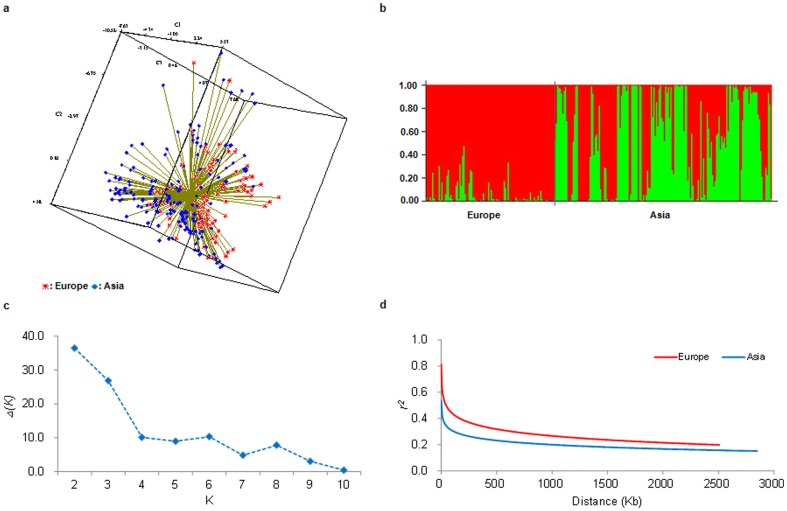
Analysis of genetic relationships, population structure and LD decay in European and Asian wheat accessions.(a) Principal coordinate analysis of European (red) and Asian (blue) accessions. (b) Bayesian clustering (STRUCTURE, K = 2) of wheat accessions. (c) Estimation of the number of populations by calculating delta K values. (d) Average LD decay in European (red) and Asian (blue) accessions.